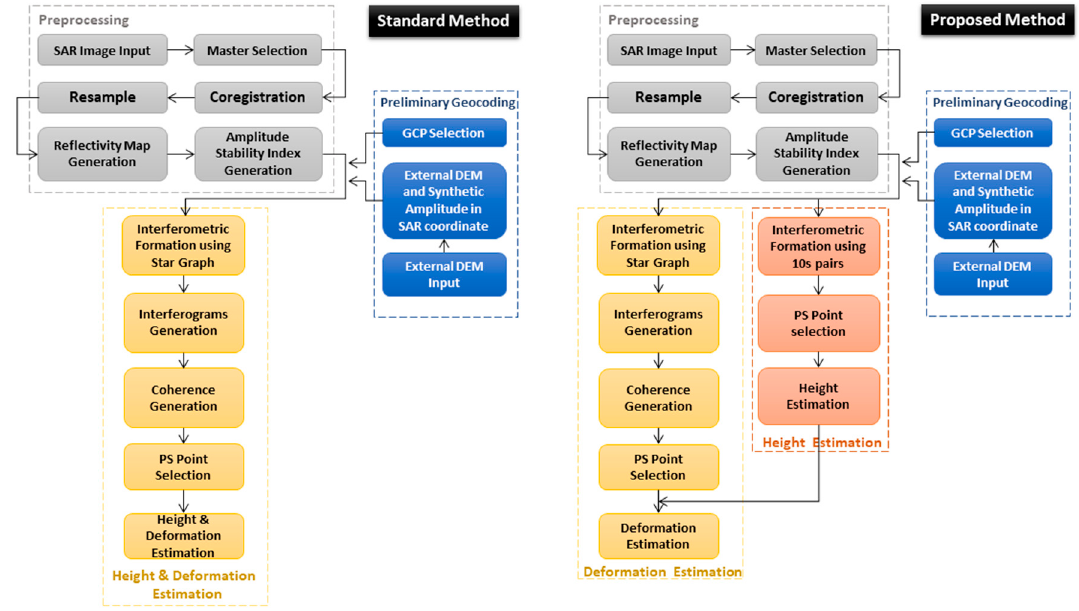
Figure 3. Flow charts of the standard processing chain ( left ) and the proposed processing method ( right ) for PS-InSAR.